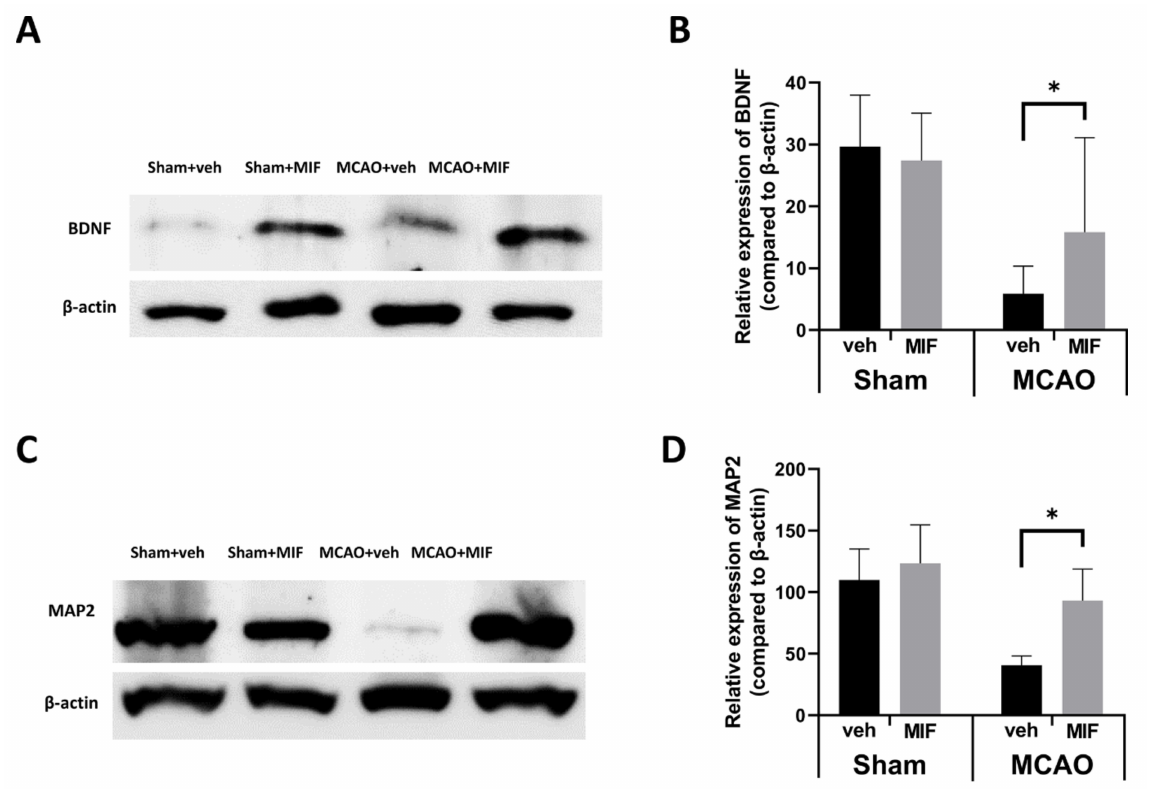
Figure 4. Changes in neuronal markers: ( A , C ) representative Western blot bands for each group are presented; ( B ) graphs showing quantification of BDNF expression in the sham and MCAO groups compared, respectively, in each group with an independent t -test. There was no significant change of BDNF expression after MIF injection in the sham group ( p = 0.503); the expression of BDNF in the MCAO+MIF group was significantly higher than in the MCAO+veh group (* p < 0.042); ( D ) the MAP2 expression of the MCAO+MIF group was significantly increased compared to that of the MCAO+MIF group (* p < 0.0001); the expression level of BDNF and MAP2 in the sham and MCAO groups were analyzed using a t -test, respectively. Mean ± SD values are presented from 12 independent experiments. MCAO: middle cerebral artery occlusion; MIF: macrophage migration inhibitory